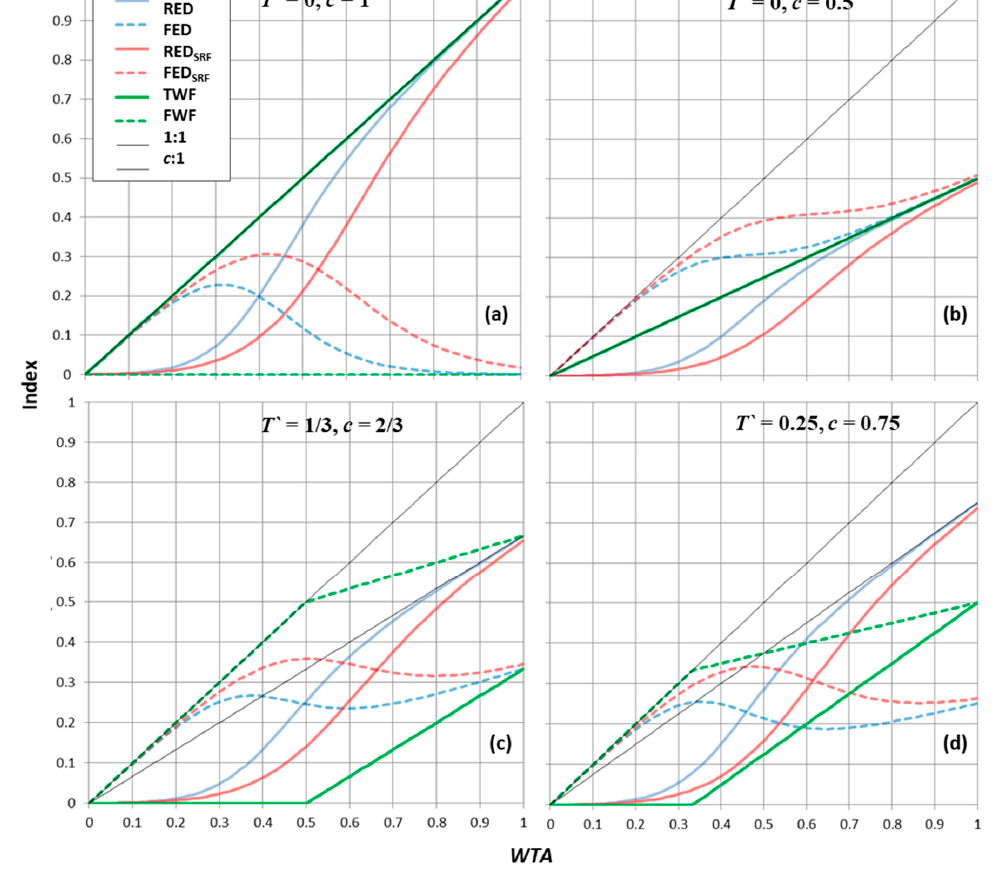
Figure 3. Comparisons between the Relevant for Environmental Deficiency (RED) midpoint impact indicator (in red, with RED Strongly Regulated Flow (SRF) version in blue) and Threshold-based Water Footprint (TWF) (in green), with different choices of threshold T‘ and mean consumptive use coefficient c, plotted against the Withdrawal-to-Availability index (WTA). BWF is coincident with the c :1 line and bounds RED and TWF. ( a ) T ‘ = 0, c = 1: “Simple Withdrawal” case where all withdrawn water is consumed and counts as adverse impact, resulting in large differences between RED and TWF and additionally Free Water Footprint ( FWF ) = 0. ( b ) T ‘ = 0, c = 0.5: “Symmetry” case resulting in a symmetry of RED and Free from Environmental Deficiency (FED) metrics about TWF and FWF, bounding of TWF and FWF by RED and FED, and TWF = FWF . ( c ) T ‘ = 1/3, c = 2/3; “Reversal” case where RED → FWF and TWF → FED as WTA → 1, and TWF = 0 when WTA < 0.5. ( d ) T ‘ = 0.25, c = 0.75; “Convergence” case where TWF converges to FWF at WTA = 1, and RED and FED metrics are bounded by TWF and FWF below WTA = 0.58.